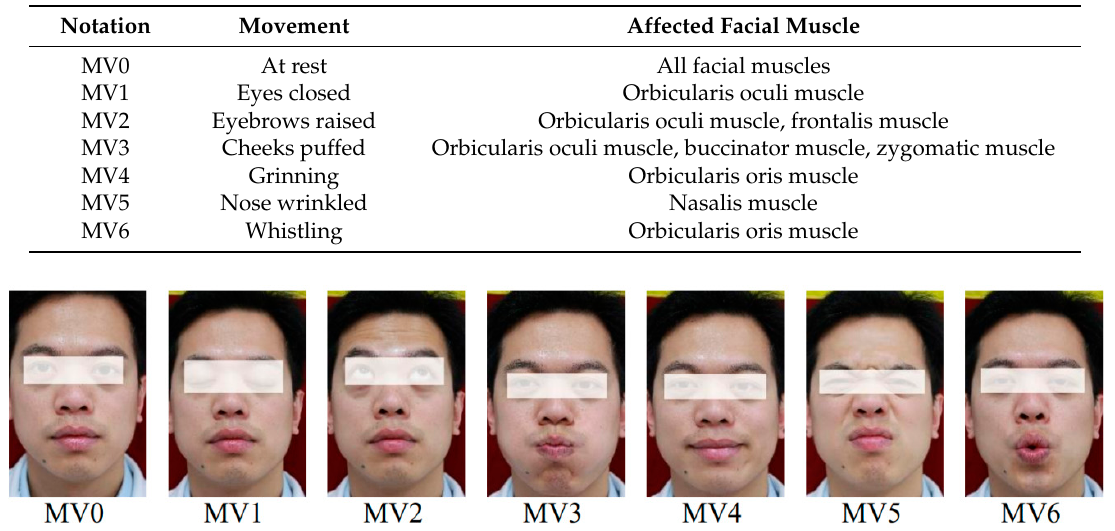
Table 2. Taxonomy movements table.